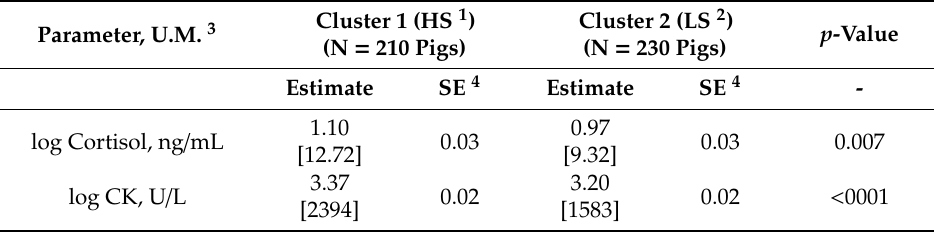
Figure 1. Three-dimensional representation of the shipments clustered according to blood cortisol and creatine kinase (CK) levels and seen from different angles ( a ) and ( b ). Each dot on the graph represents a shipment. Cluster 1 (red color, 21 shipments), Cluster 2 (green color, 23 shipments). The colored area represents the area around the cluster centroid. Table 2. Summary of the characteristics of the two clusters (backtransformed data are presented between square brackets).